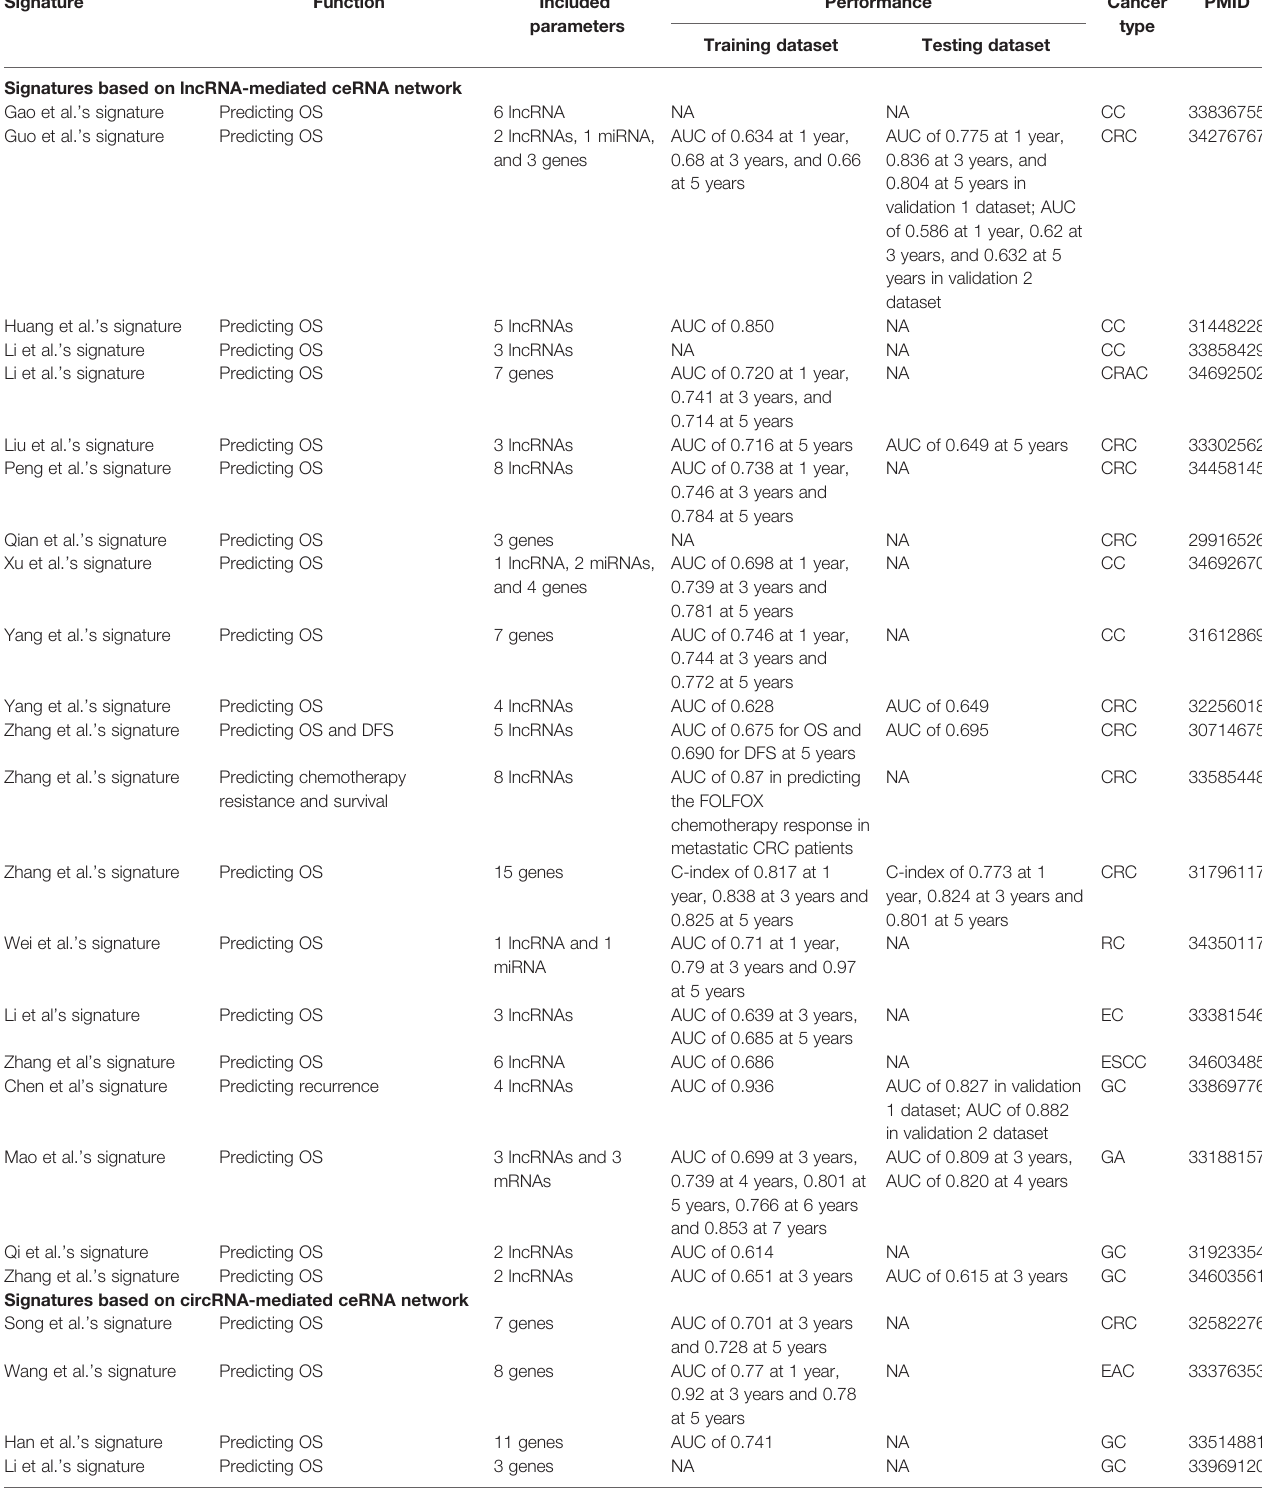
TABLE 2 | ceRNA network-based prognostic signatures in